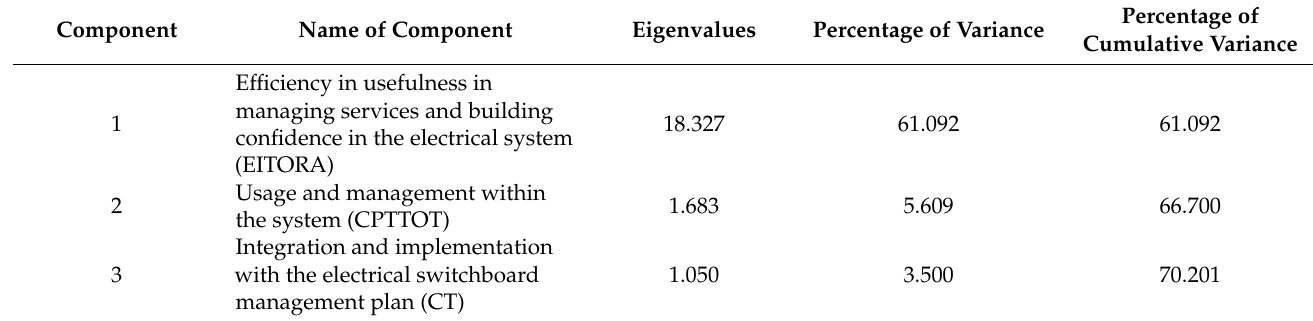
Table 3. Results of composition analysis of intranet sensors system efficiency and acceptance for electrical switchboard management.